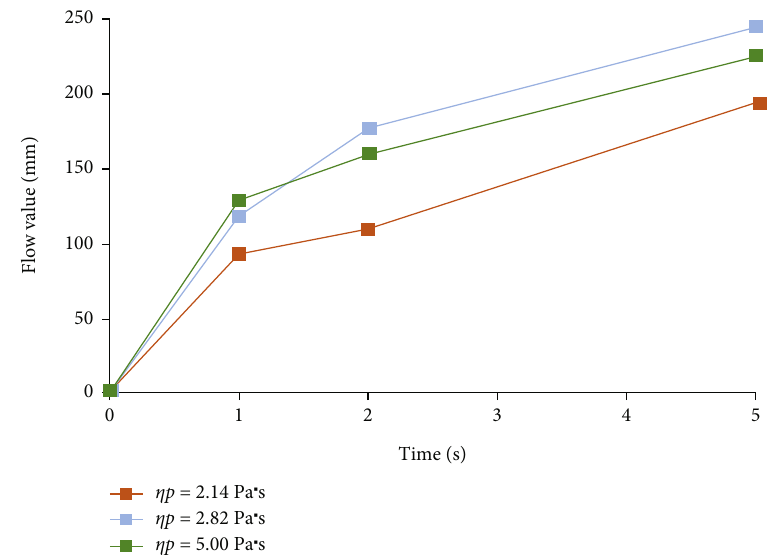
Figure 4: Relationship between fl ow value and time with di ff erent plastic viscosity.